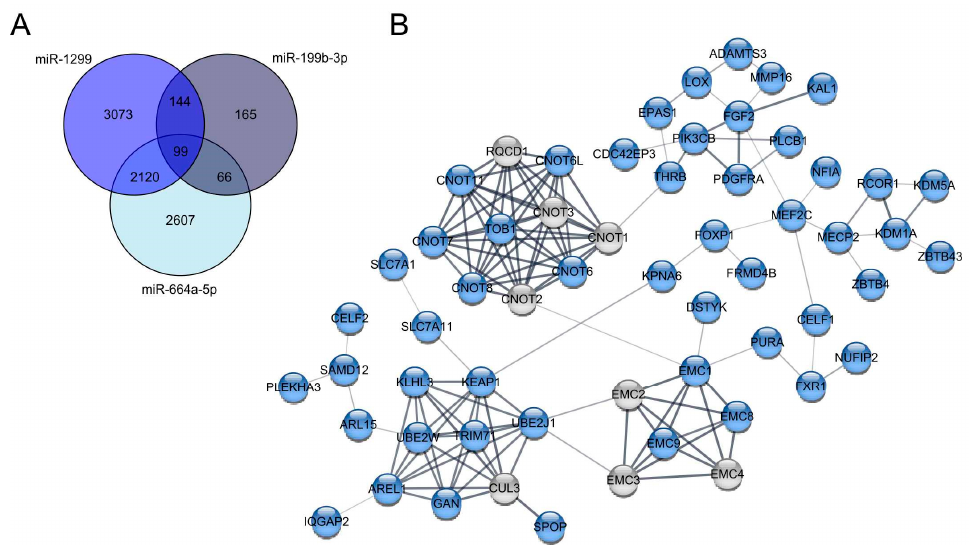
Figure 6. Target gene analysis of strongly downregulated miRNAs in melanoma compared to MBrCs and NHEMs. ( A ) Venn diagram of shared predicted targets of miR-1299, miR-199b-3p and miR-664a-5p. ( B ) STRING network analysis of selected target genes of the 99 shared targets of miR-1299, miR-199b-3p, and miR-664a-5p (blue), which belong to one network and additional genes involved in the network (grey).